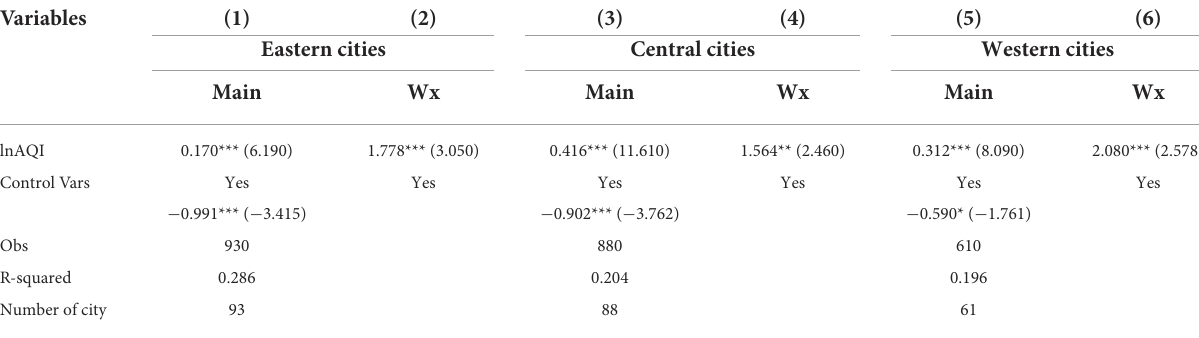
TABLE 5 Impact of air quality improvement on enterprise productivity in eastern, central and western